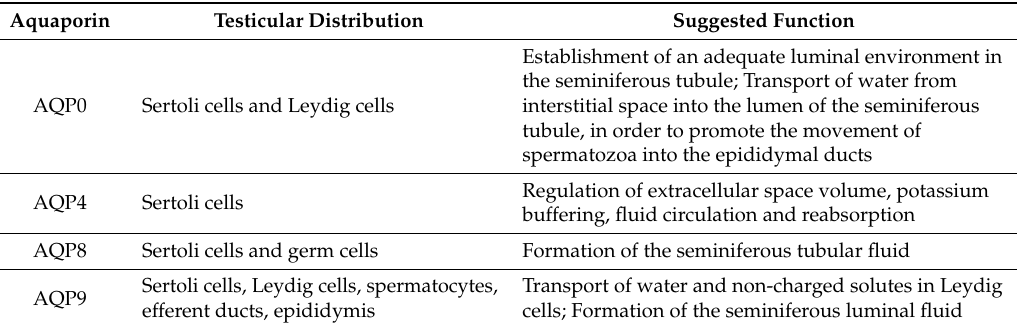
Table 2. Sertoli cell distribution and possible functions of mammalian